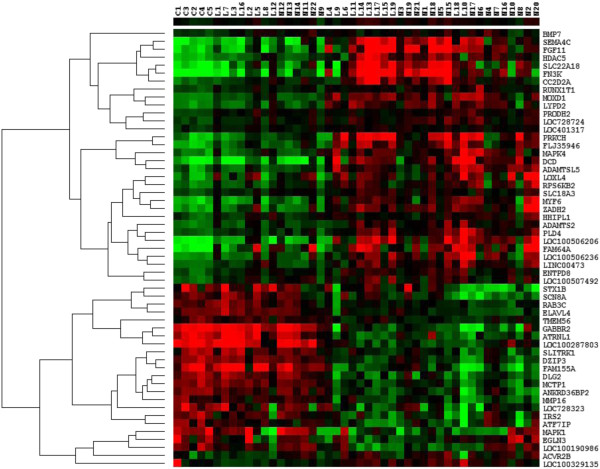
Differentially expressed mTOR genes in the frontal lobe of AD patients. Heat map of differentially expressed mTOR genes in the frontal lobe of AD patients compared to control. Differential expression was determined by multiclass analysis in SAM, with the subjects split into three groups according to Braak staging: control, mild AD (limbic stage) and advanced AD (neocortical stage). The cut-off point for differential expression was <10% FDR. The heat map was generated with Cluster and Treeview, with complete hierarchical clustering by gene and array. The expression level of each gene relative to the median expression of the gene across all samples is represented on a red-green colour scale. The colours represent the log ratio of gene expression in an individual patient. Downregulated genes are represented in green (saturated green: log ratios −3.0 and below) while upregulated genes are represented in red (saturated red: log ratios 3.0 and above). Cells with log ratios of 0 (gene expression unchanged) are black. The arrays are identified by the patient codes that are described in Additional file 2: Table S1 (C: Control, L: Limbic stage AD, N: Neocortical stage AD) while the genes are identified by the gene name.